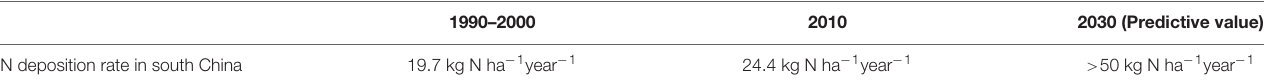
TABLE 1 | The change of nitrogen deposition rate in South China from 1990 to 2010 and the predicted value of nitrogen deposition rate in 2030 (Bobbink et al., 2010).